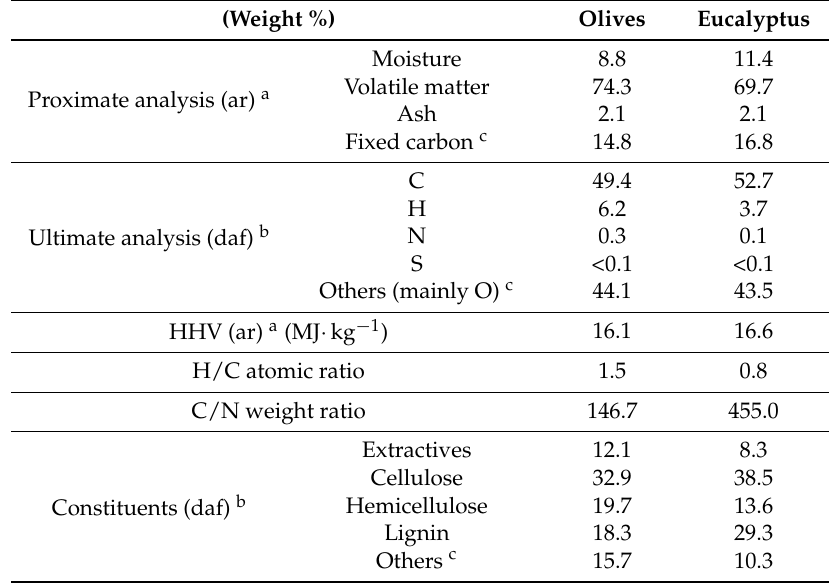
Table 1. Proximate, ultimate and constituents analyses of the original pyrolyzed biomass samples. (Weight %) Olives Eucalyptus